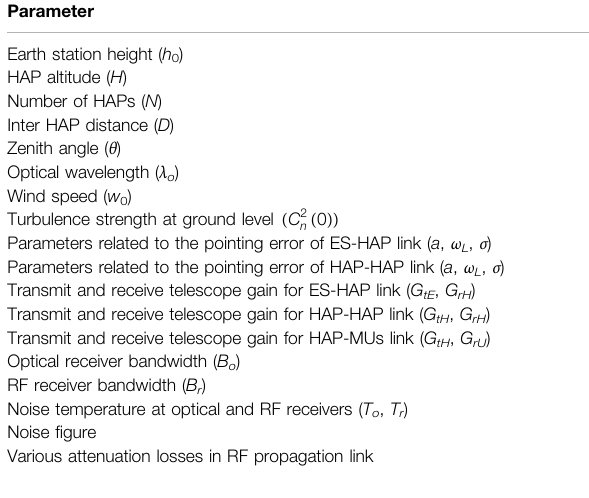
TABLE 3 | Various parameters of interest.